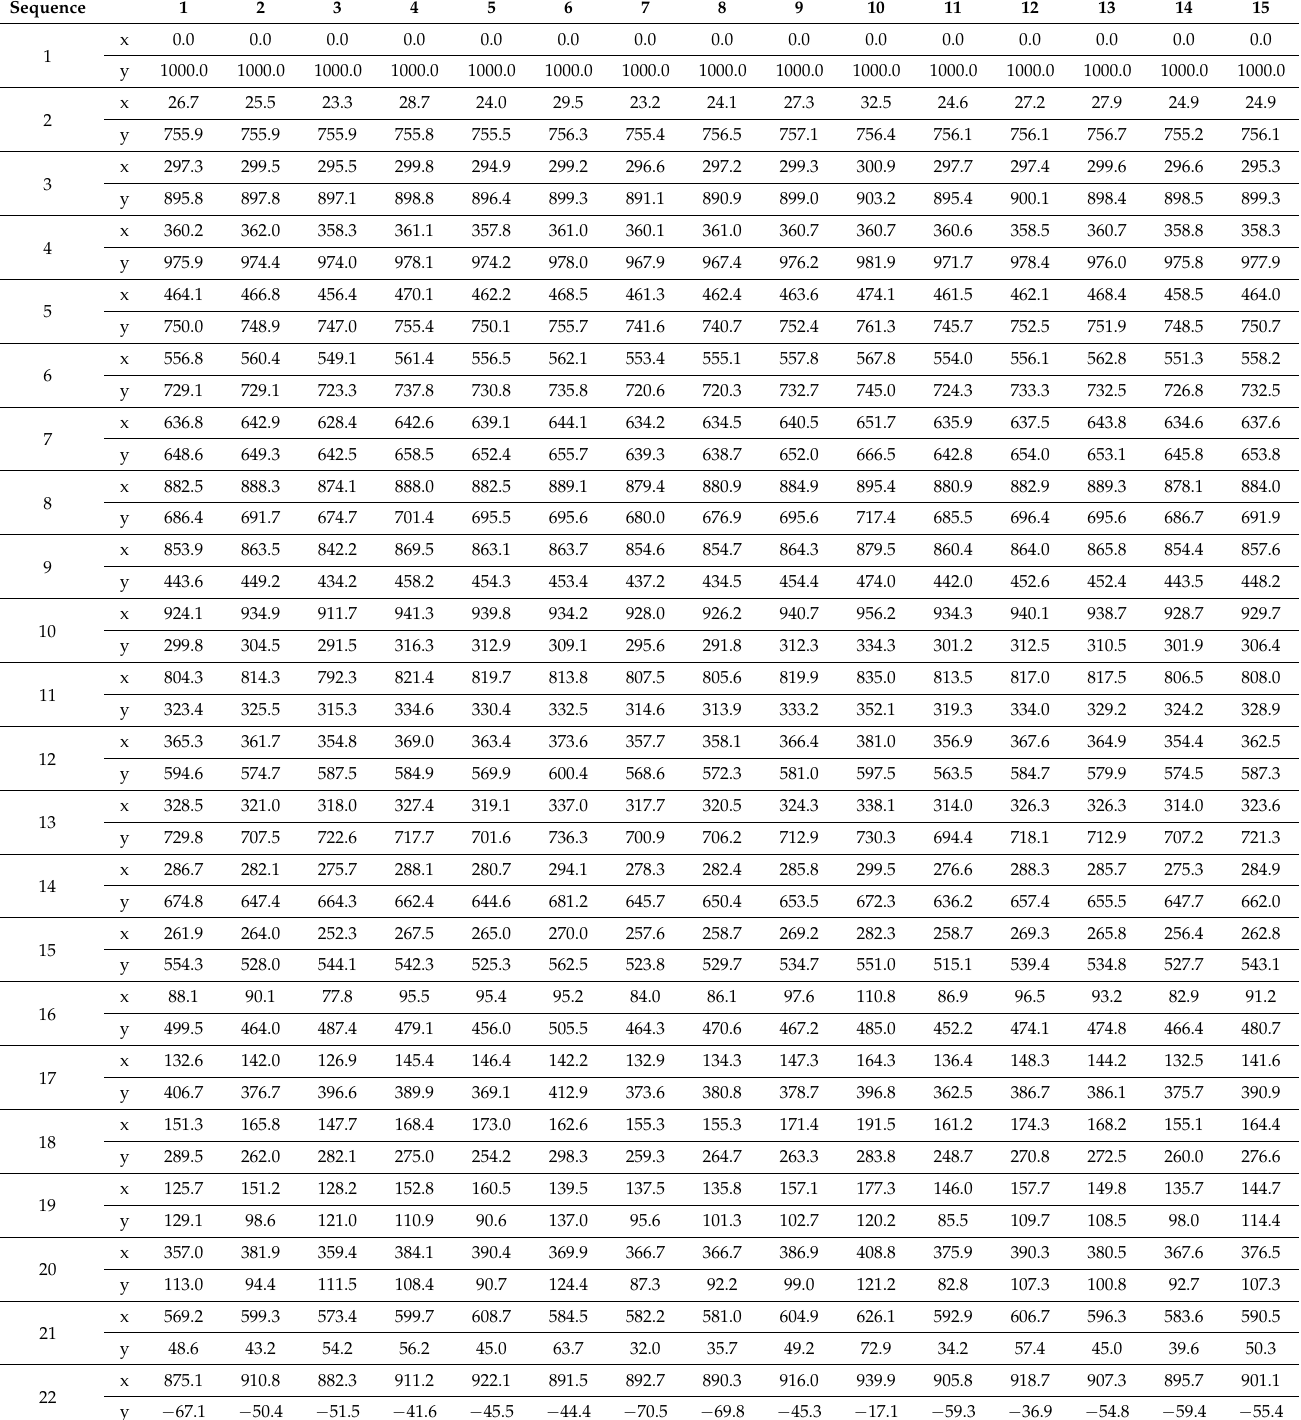
Table A7. Experiment data when moving along the path with the shortest length. The movement commands have not been compensated